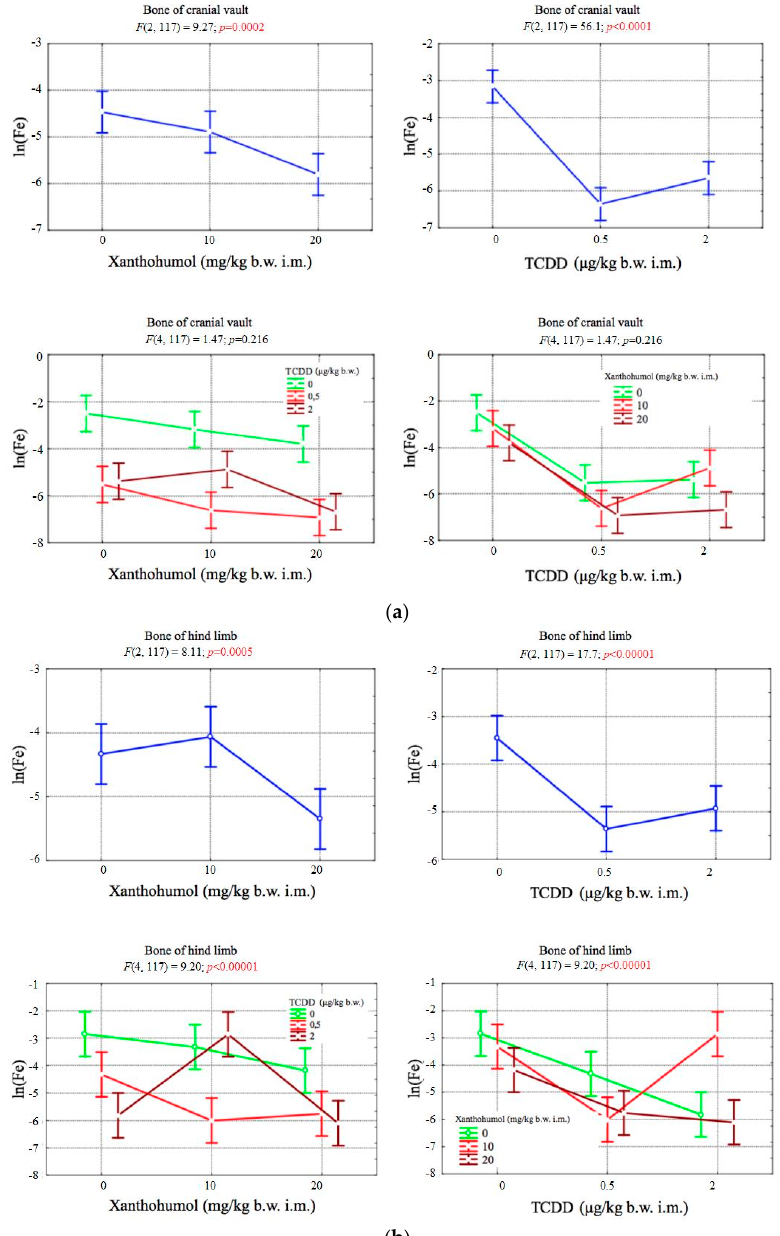
Figure 5. ( a ) Average iron concentration (transformed variables) in the bone of the cranial vault, depending on the dose of TCDD and xanthohumol, and results of the significance test. Results are represented as mean ± SD. p ≤ 0.05 was considered statistically significant. Significant p value is highlighted in bold. ( b ) Average iron concentration (transformed variables) in the bone of the hind limb, depending on the dose of TCDD and xanthohumol, and results of the significance test. Results are represented as mean ± SD. p ≤ 0.05 was considered statistically significant. Significant p value is highlighted in